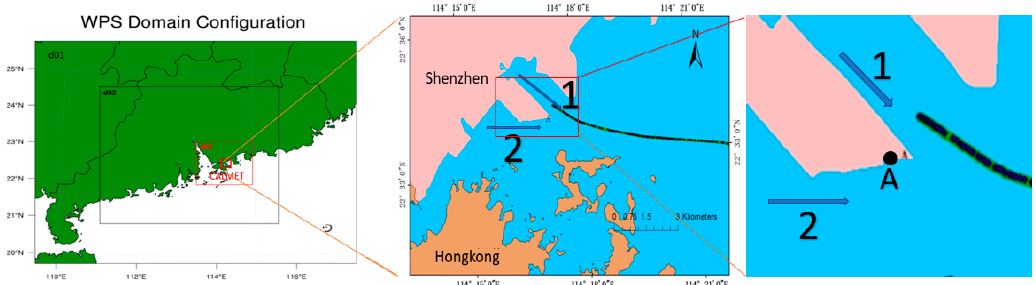
Figure 1. Left: Weather Research and Forecasting Model (WRF) three-layer nesting and CALMET area; Right: Yantian port (Point A is the location of the shore-based monitoring instrument and the numbers 1 and 2 indicate the two waterways when the ship leaves the port).